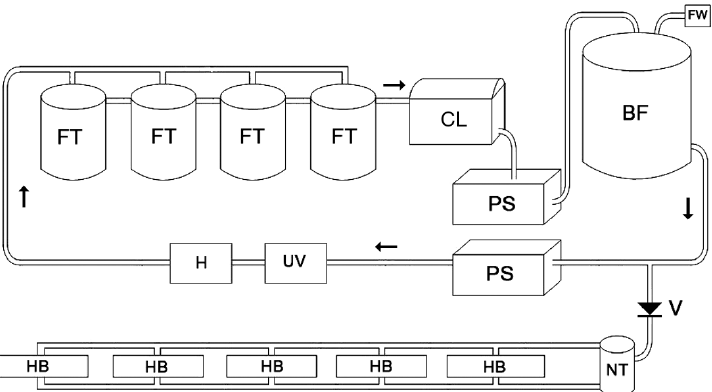
Fig. 1. Coupled aquaponic system, comprising a recirculating aquaculture system and a hydroponic unit. FT: fish tank(tanks are set up in parallel, with each outflow draining to the clarifier via an open channel behind the tanks); CL: clarifier; PS: pump sump; BF: biofilter; FW: fresh water supply; UV: UV disinfection unit (optional); H: heater (optional); HB: hydroponic beds (nutrient flow technique); NT: nutrient media reservoir; V: 1-way valve